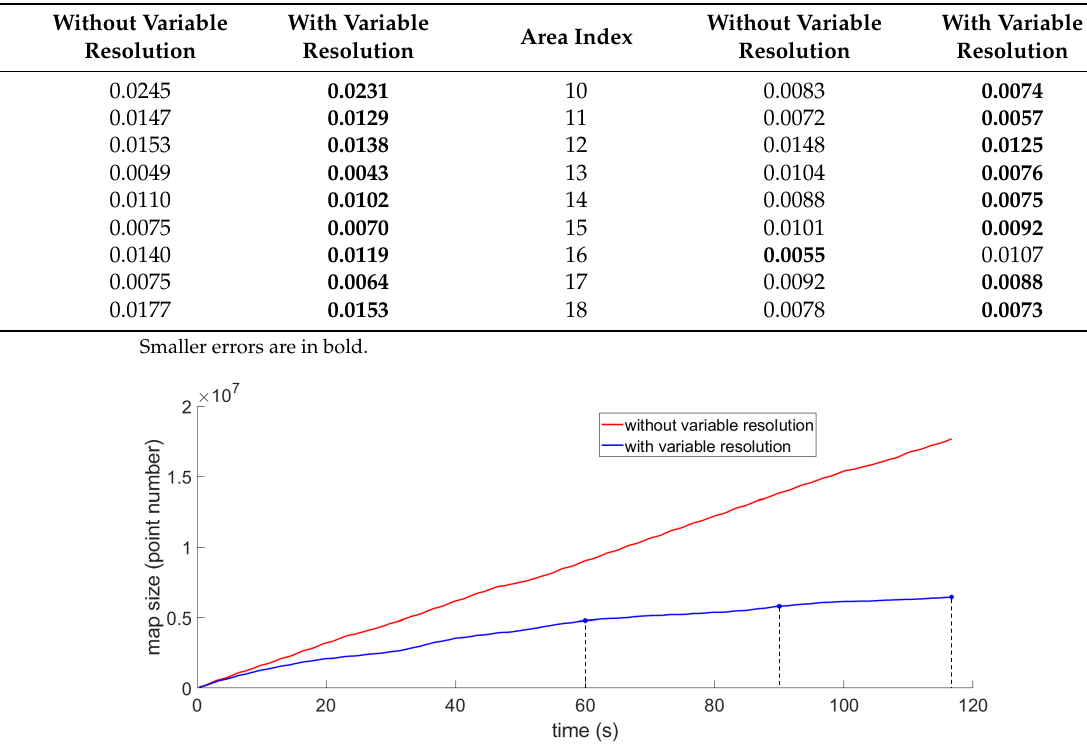
Figure 14. The selected areas of the conference room environment used to calculate the mapping error. Several kinds of regions are selected and colored separately, with each type of region colored in the same color. Areas 1–6 are the ceiling, areas 7–9 are the floor, areas 10 and 11 are the walls, areas 12–15 are the chairs, and areas 16–18 are the tables. Table 7. The mapping error (MAE/m) comparison of the conference room environment.